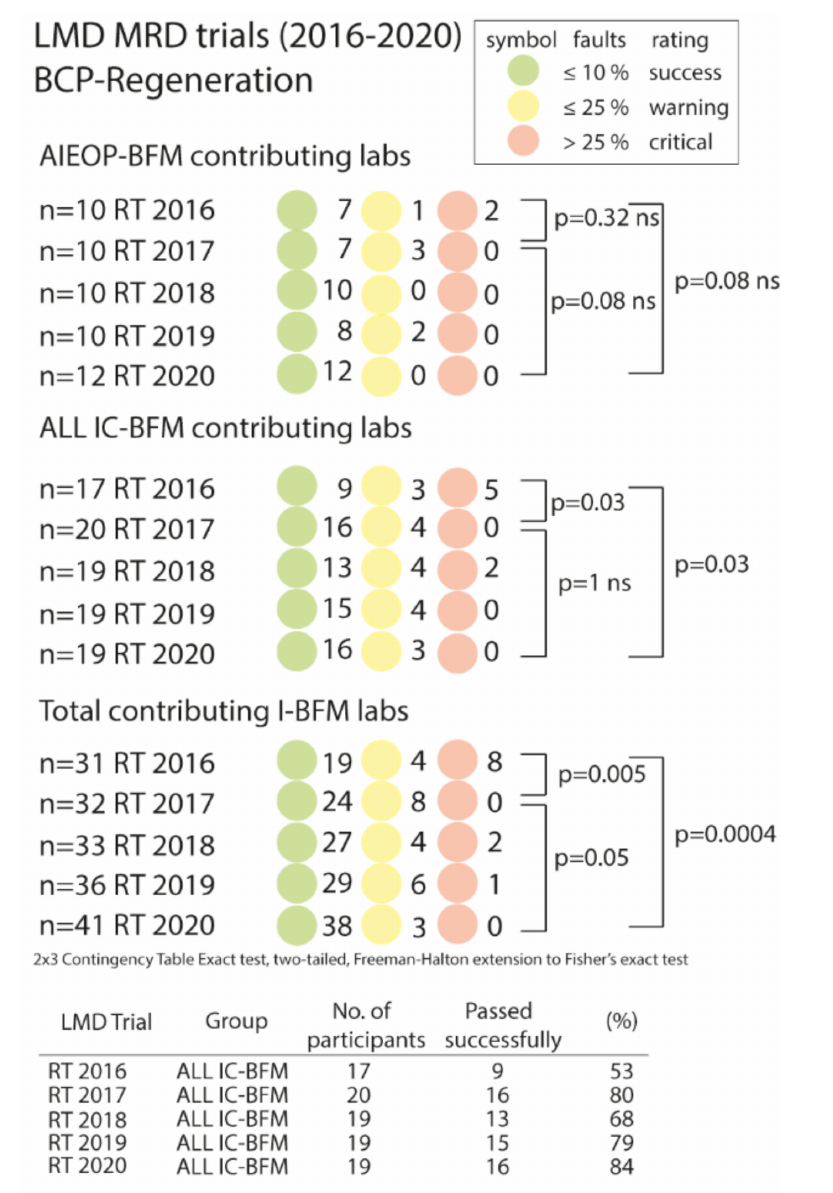
Figure 3. Regular ring trial tests using the list-mode file sent around reveal a significant performance improvement. LMD Files from 20 B-ALL cases at day 78 or after relapse therapies were sent out to all participating laboratories once a year. Laboratories, which reported false MRD values in >10%– ≤ 25% of cases were flagged with a warning (yellow circle) and reports with >25% false MRD values were considered to be critical (red flag). Total contributing I-BFM labs contained AIEOP-BFM, ALL IC-BFM, and other associated laboratories. Statistical analysis was performed using a 3 × 2 contingency table and two-sided Fisher’s